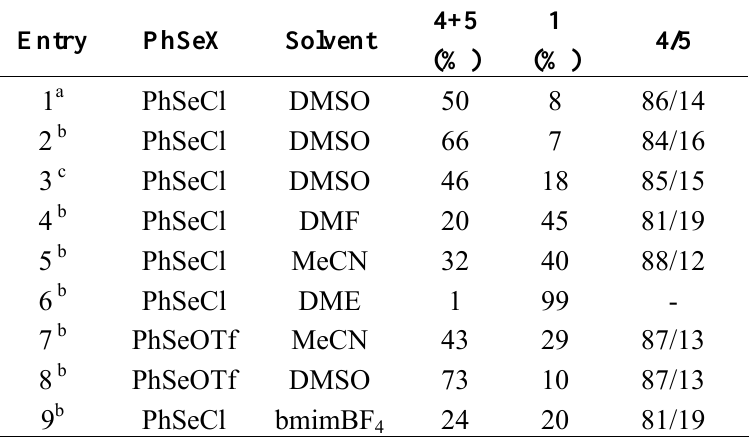
Table 2 . Azido selenenylation of compound 1a